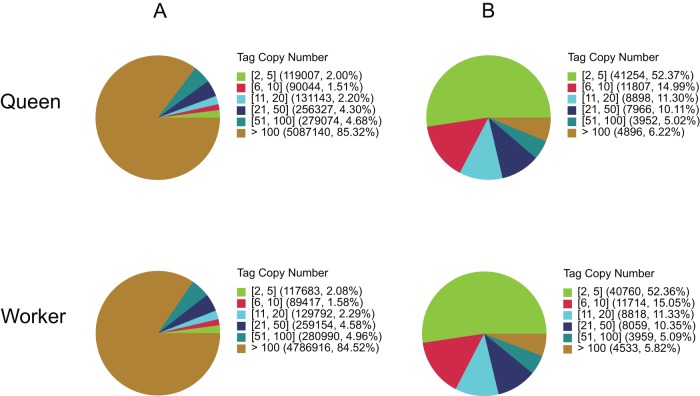
Distribution of total clean tags (A) and distinct clean tags (B) over different tag abundance categories in each sample.Numbers in the square brackets indicate the range of copy numbers for a specific category of tags. For example, [2], [5] means all the tags in this category has 2 to 5 copies. Numbers in the parentheses of (A) and (B) respectively show the total copy number of the clean tags and the total types of clean tags in that category.